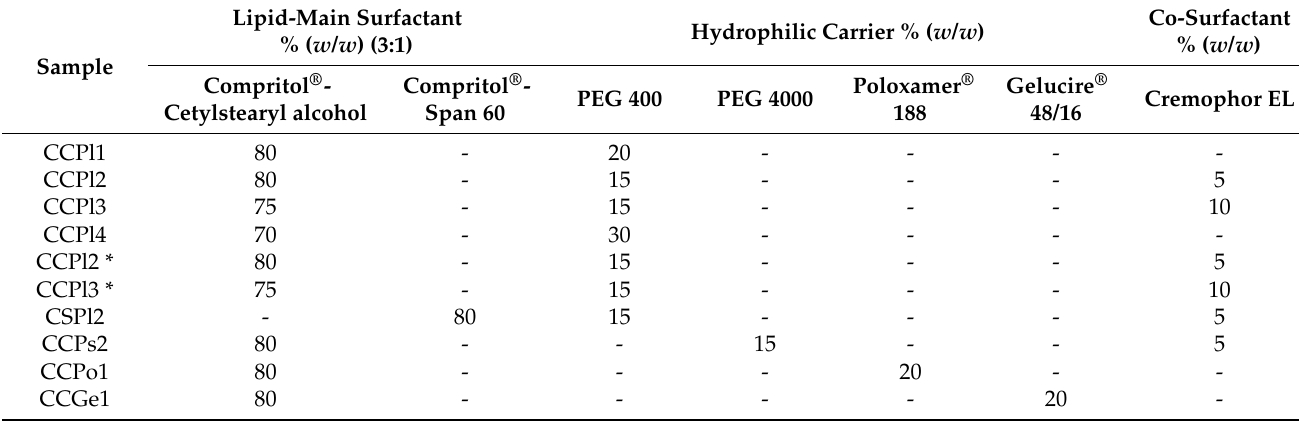
Table 3. Composition of the emulsions with Compritol ® 888 ATO as